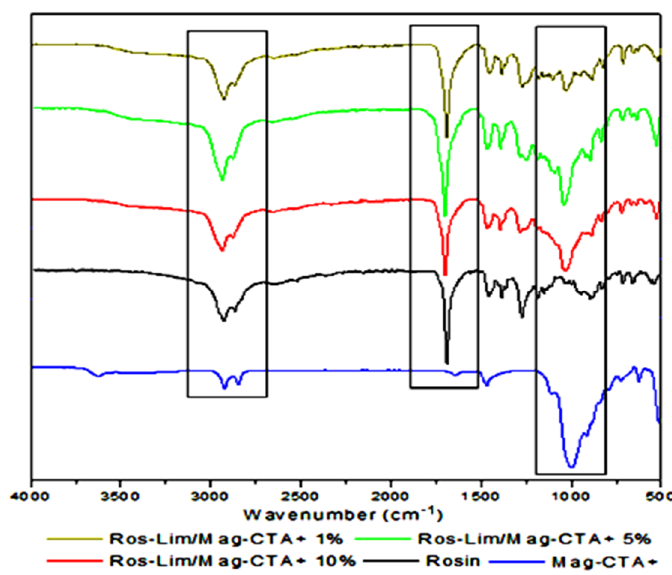
Figure 3. FT-IR spectra of the obtained nanocompositesRos-Lim / Mag-CTA + .